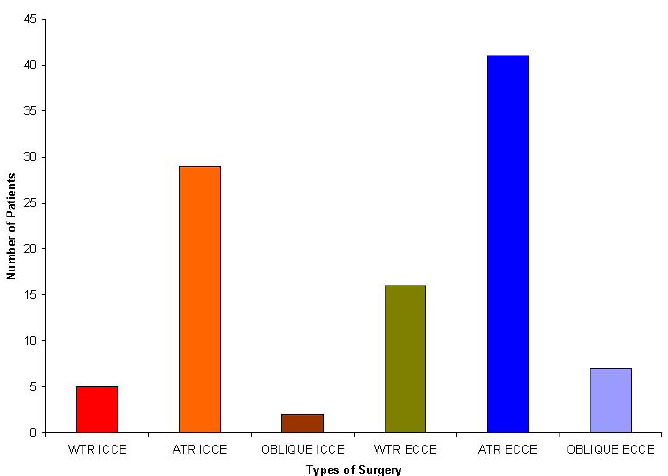
Figure 4 The different types of Astigmatism in various surger-